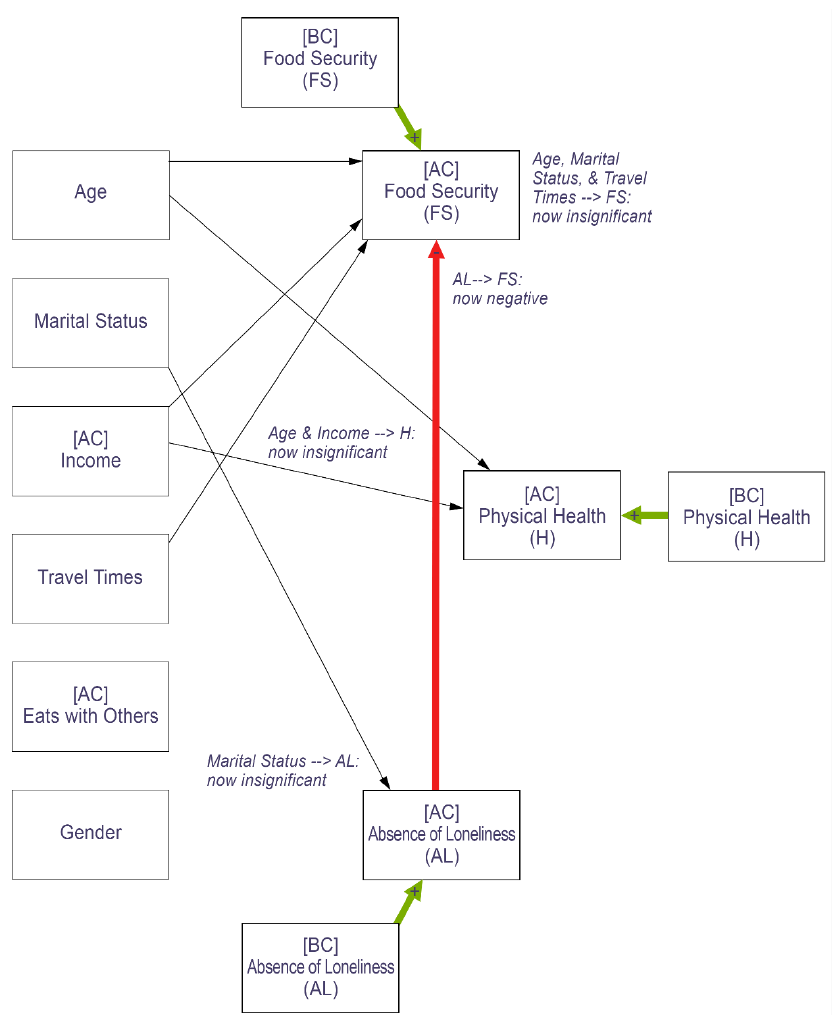
Figure 3. Path analysis results showing the differences in relationships after controlling for before- COVID food security, health, and loneliness (compared to the during-COVID path analysis). Thick lines represent significance at α = 0.05. Thin lines represent insignificance. Green represents positive relationships and red negative relationships.